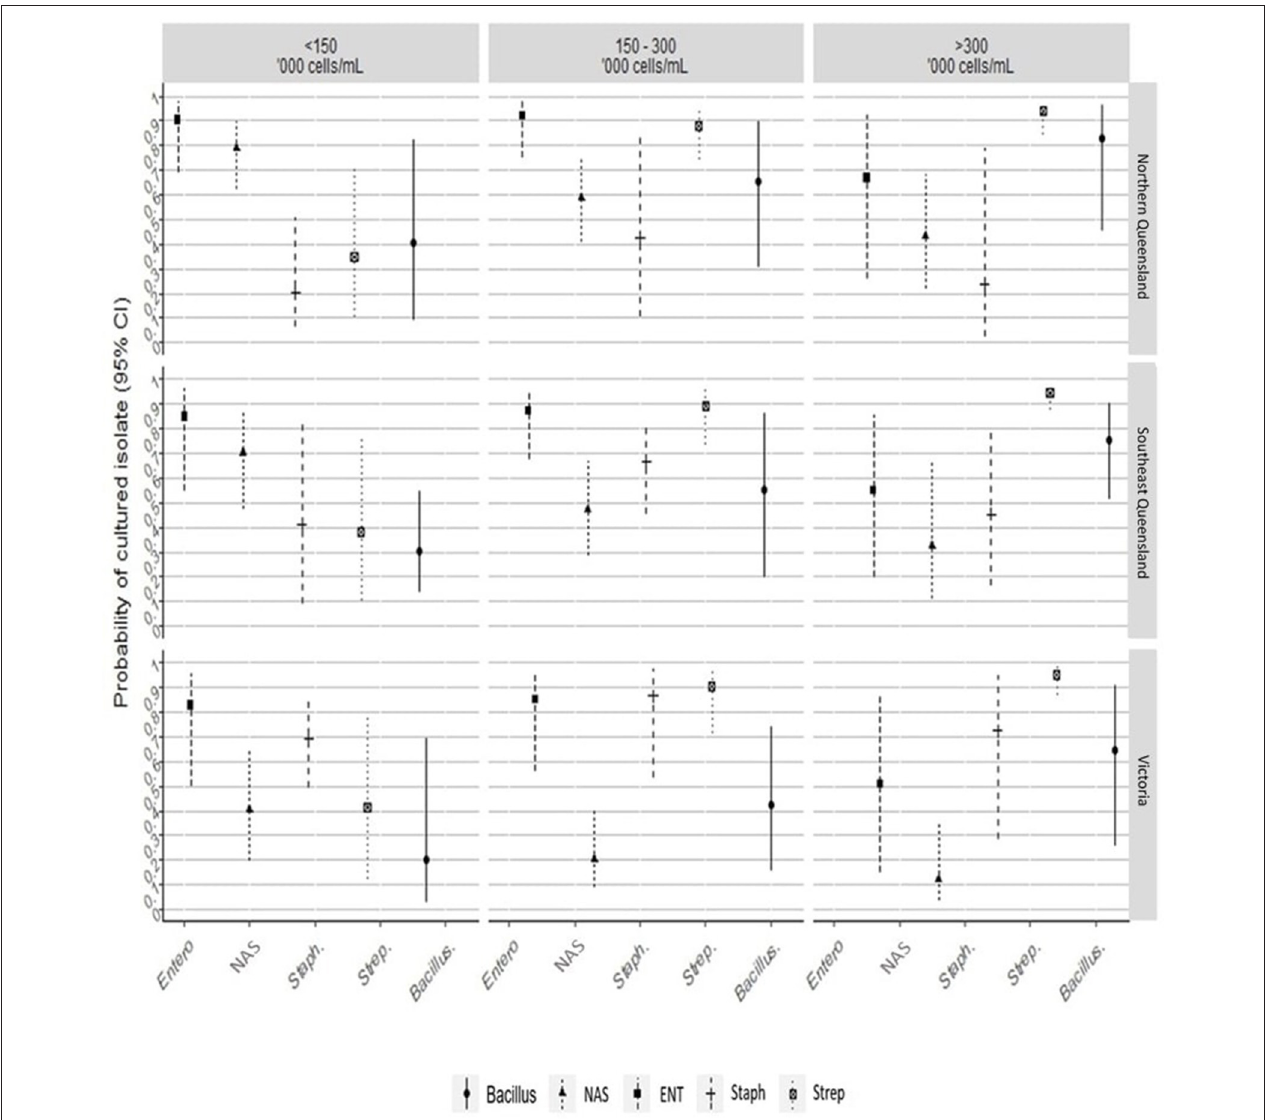
FIGURE 3 | The line plot shows the probability of culturing a bacterial group from mastitis and healthy quarters, between herd’s region, and average bulk milk somatic cell counts. Entero/ENT, Enterobacteriaceae ; NAS, non-aureus staphylococci; Staph, Staphylococcus aureus ; Strep, Streptococcus spp.